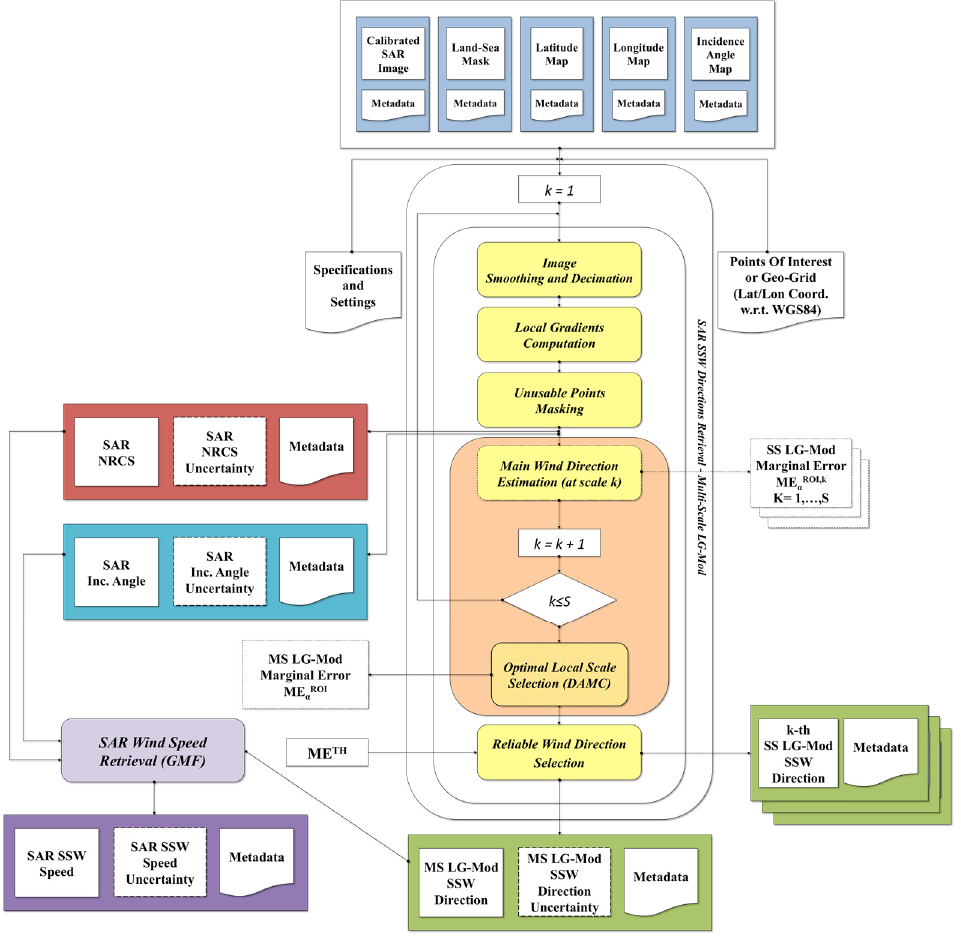
Figure 2. The scheme of the proposed methodology for the estimation of Synthetic Aperture Radar (SAR) Sea Surface Wind (SSW) speed and its uncertainty, and the Multi-Scale (MS) Local Gradient-Modified (LG-Mod) processing flowchart.